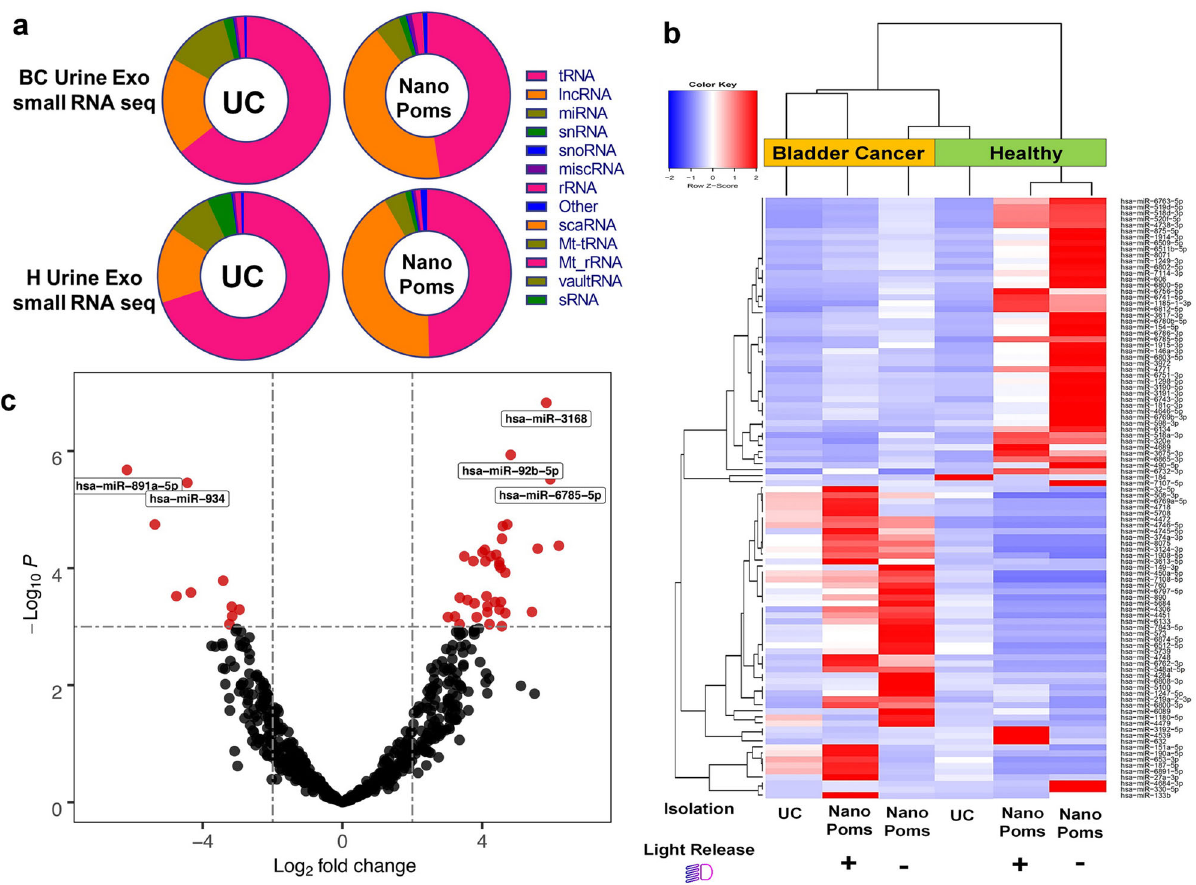
Fig. 4 The NGS analysis of small RNAs from bladder cancer patient urinary exosomes. a The distribution of small RNA categories from both NanoPoms and UC prepared urinary exosomes in BC patients and healthy individuals. b Heatmap with dendrogram clustering analysis depicts the top 100 highly expressed miRNAs from urinary exosomes isolated from both BC patient and healthy individual using UC, NanoPoms, and NanoPoms without light release process. Red color indicates a higher expression z-score. Hierarchical clustering was performed, using the Spearman correlation method. NanoPoms isolation approach with or without light release processes have been clustered together due to higher similarities in their transcript expressions. c Volcano plot analysis depicts the most biologically signi fi cant urinary exosome miRNAs with large fold changes identi fi ed by using NanoPoms preparation compared to UC preparation. Top 5 highly signi fi cant miRNAs are labeled in plot, which are from NanoPoms